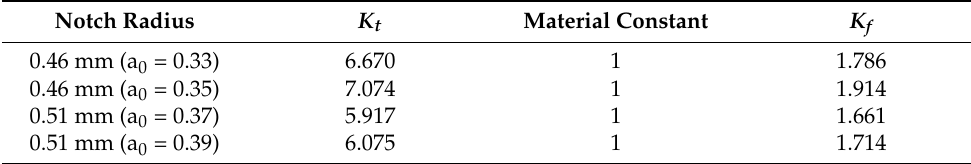
Table 7. Parameters of notch radius/ K t /material constant/ K f . (PP with glass